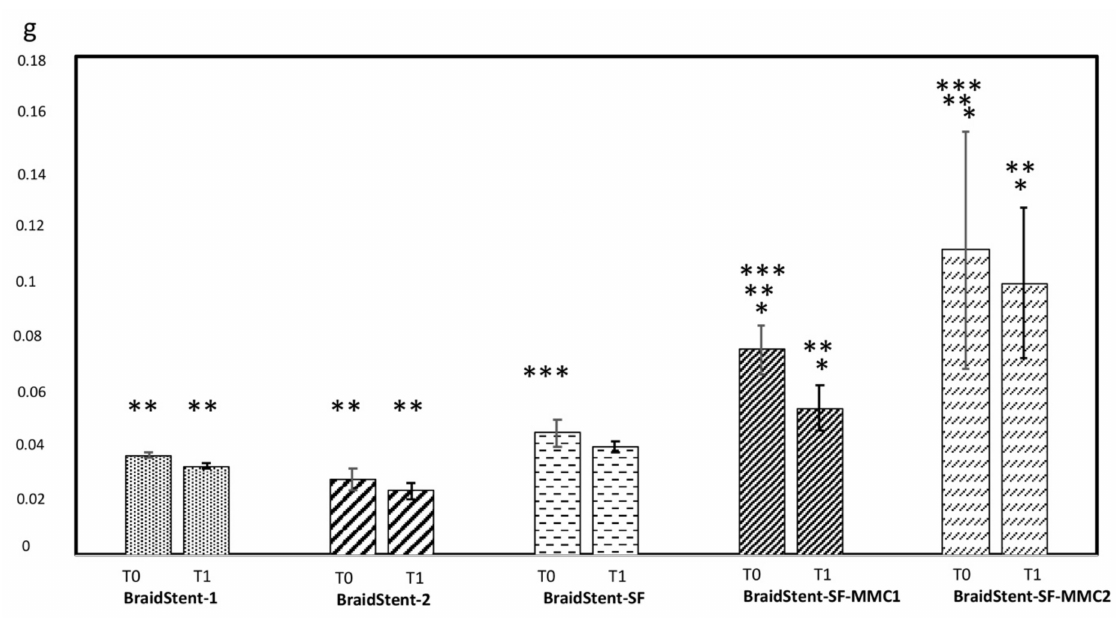
Figure 4. Assessment of weight loss (grams) between the start of the study (T0) and the start of stent degradation (T1). Values indicate mean ± SD. Significance of the values between each tested groups at T0 and T1 was determined by the Kruskal–Wallis H test and post hoc pairwise comparison. Wilcoxon test was used to analyze weight loss from T0 to T1 within each group. Significant differences are expressed as: intra-groups (* p < 0.05); inter-groups (** p < 0.05) (BraidStent-1 vs. BraidStent-2; BraidStent-SF-MMC1 vs. BraidStent-SF-MMC2); inter-groups (*** p < 0.05) (BraidStent-SF vs. BraidStent-SF-MMC1 and BraidStent-SF-MMC2).